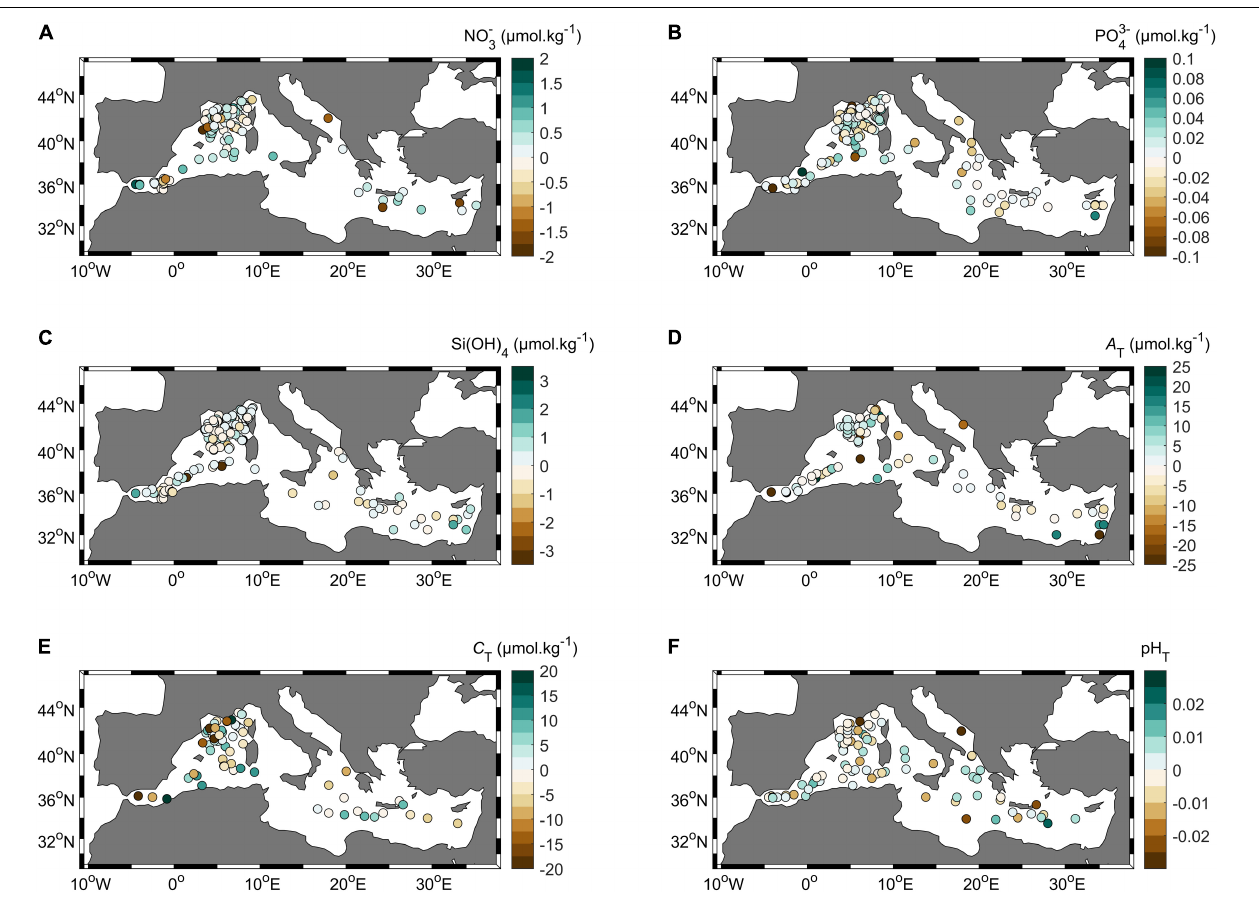
FIGURE 7 | Difference between in situ measurements and the corresponding values predicted by CANYON-MED averaged from 1000 m to the bottom for (A) NO − 3 , (B) PO 3 − 4 , (C) Si(OH) 4 , (D) A T , (E) C T , and (F) pH T